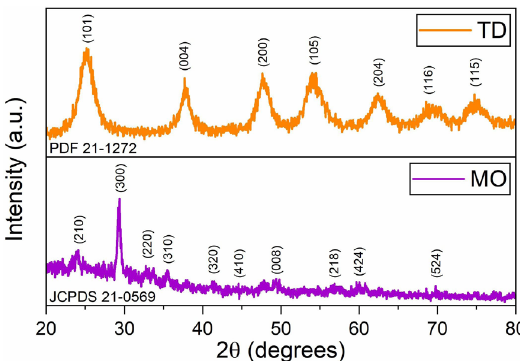
(TD)annealed at 550 °C and 2 (MO) thin films . 3